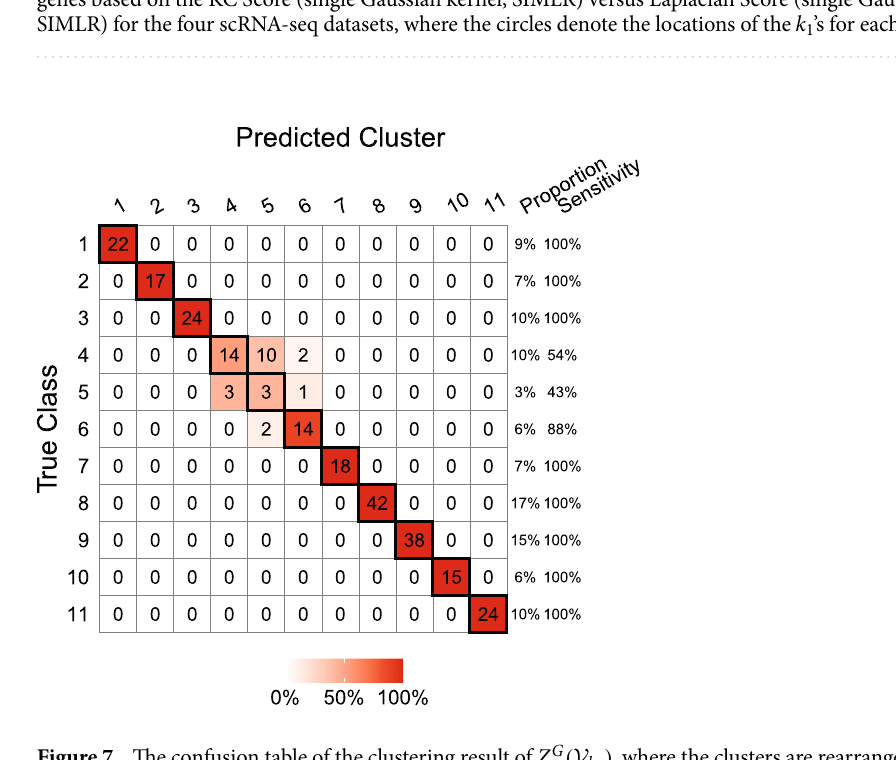
Figure 7. The confusion table of the clustering result of Z highest